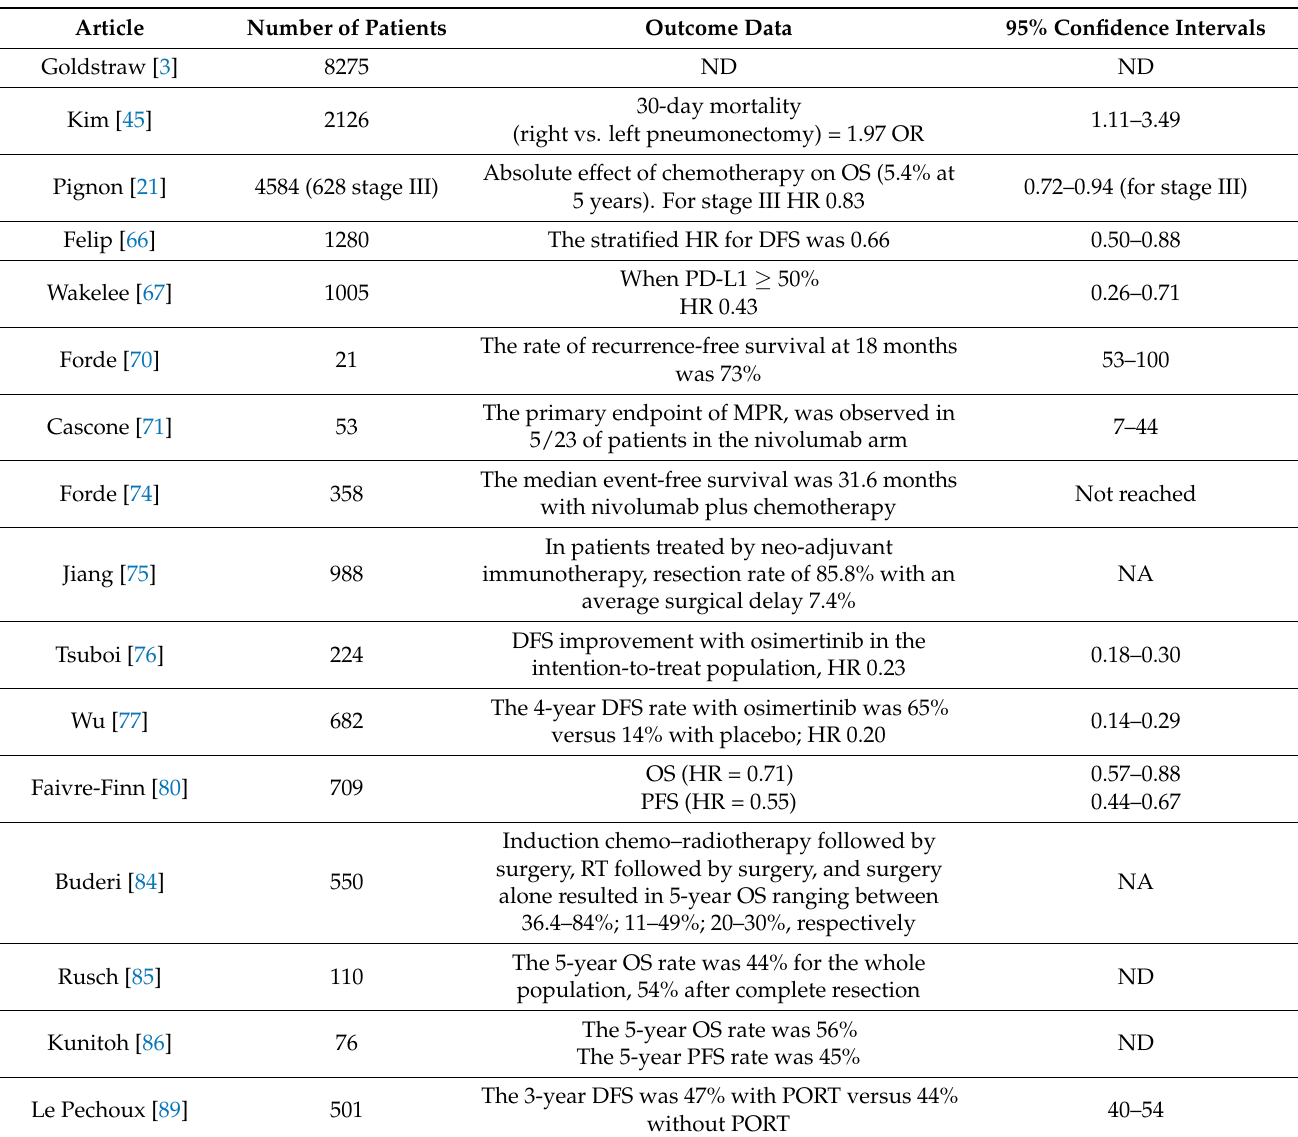
Table 2. Number of patients and outcome data with confidence intervals, for the included articles, where